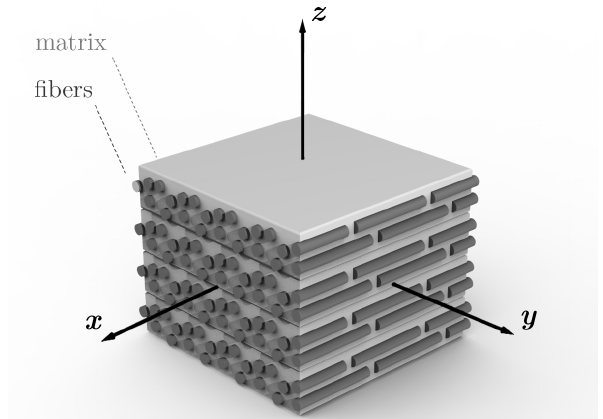
Figure 5. Rendering of an RVE with aligned fibers, powder spreading ( x ), transversal ( y ) and build directions ( z